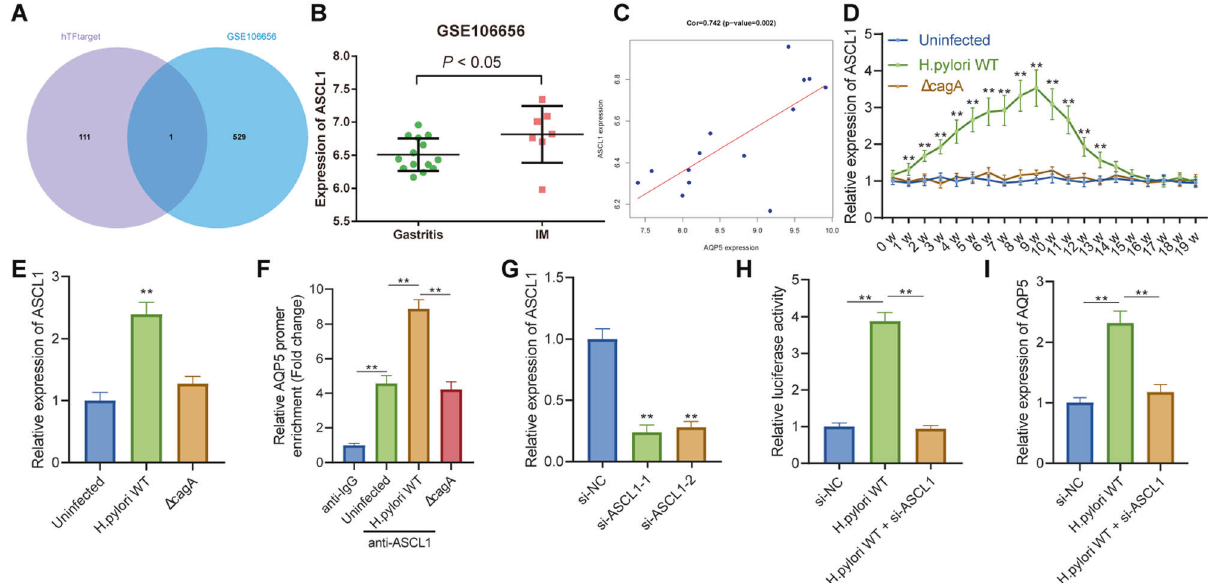
Fig. 3 H. pylori augments AQP5 expression by upregulating ASCL1. A Veen map of the transcription factors binding AQP5 predicted by hTFtarget database and AQP5-related genes in microarray data GSE106656. B , ASCL1 expression in 14 gastritis patients and 7 IM patients in microarray data GSE106656. C Correlation between ASCL1 and AQP5 expression in microarray data GSE106656. D ASCL1 mRNA level in mouse gastric mucosa measured by RT-qPCR ( n = 6). E , ASCL1 mRNA level in mouse primary GECs measured by RT-qPCR. F Enrichment of ASCL1 on the AQP5 promoter detected by ChIP assay. G The silencing ef fi ciency of si-ASCL1-1 or si-ASCL1-2 as re fl ected by ASCL1 mRNA level in mouse primary GECs transduced with si-ASCL1-1 or si-ASCL1-2 measured by RT-qPCR. H The target relationship between ASCL1 and AQP5 veri fi ed by dual luciferase reporter assay. I ASCL1 mRNA level in H. pylori-i nfected mouse primary GECs transduced with si-ASCL1 measured by RT-qPCR. * p < 0.05, ** p < 0.01. Data were shown as the mean ± standard deviation. Cell experiments were repeated three times independently. Comparisons of data between two groups were analyzed by independent sample t- test. One-way ANOVA with Dunnett ’ s post hoc test was applied for the comparison of data among multiple groups. The data between groups at different time points were compared by repeated measures